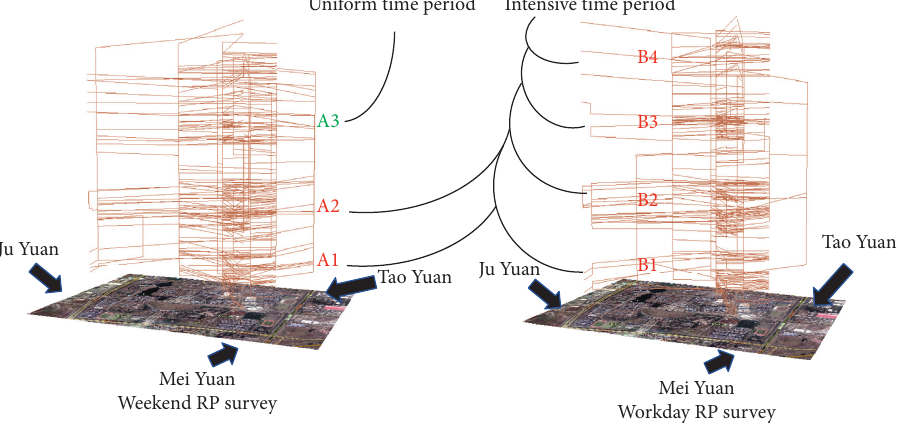
Figure 8: Activity travel path under RP survey.